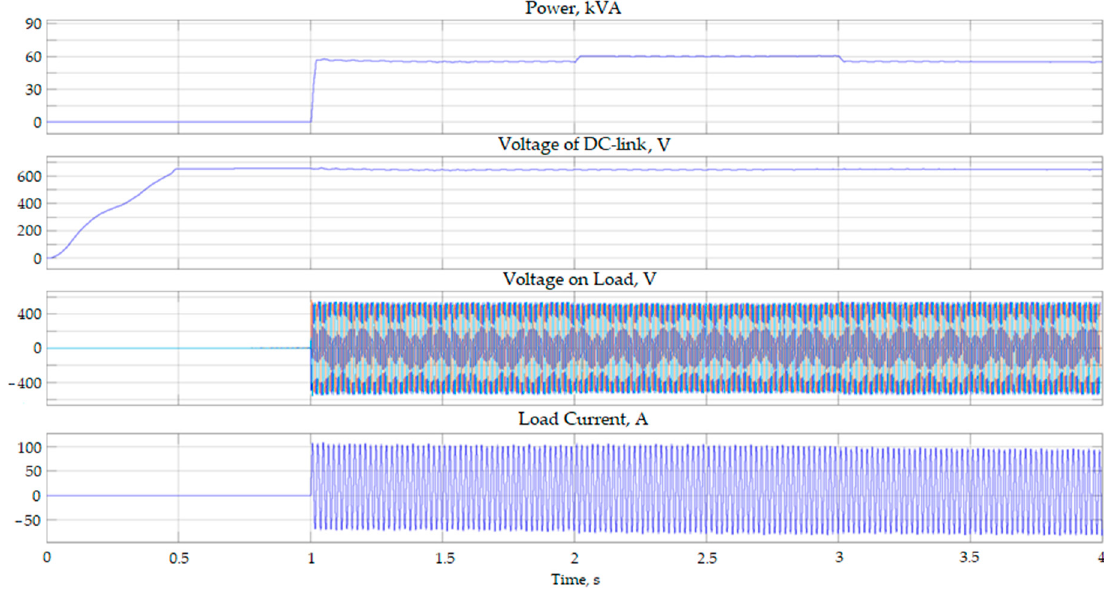
Figure 9. Voltage oscillograms on the DC bus, load line voltage, and load current during gas turbine operation.